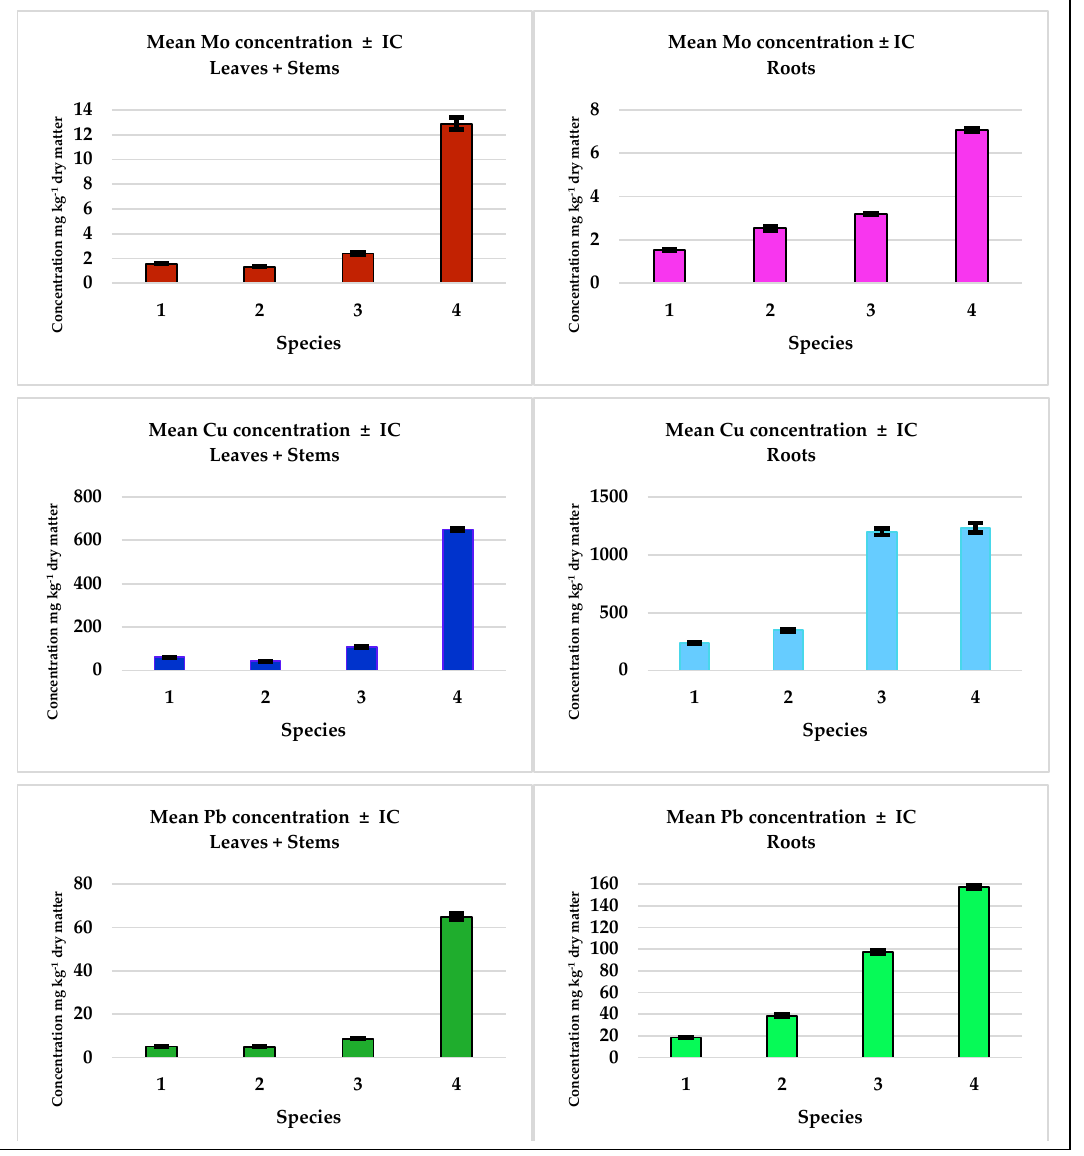
Figure 3. Mean concentration ± IC of Mo, Cu and Pb in roots and aerial parts, where, 1: Oxalis gigantea , 2: Cistanthe grandiflora , 3: Puya berteroniana , 4: Solidago chilensis . The plant species used in the present research have not been studied before for